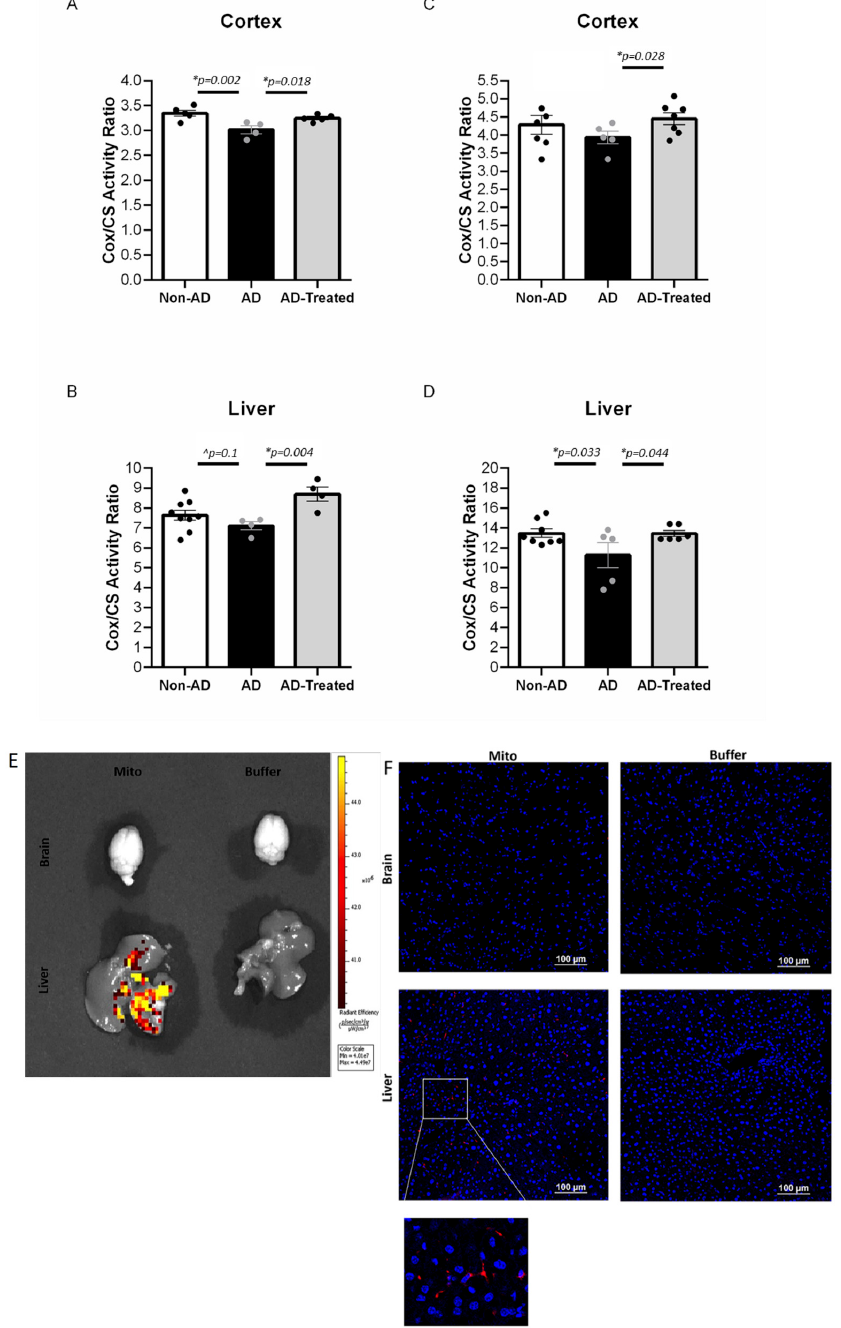
Figure 3. Increased mitochondrial enzymatic activity in the brain and liver of AD mice treated with mitochondrial transfer (A–D). Injected mitochondria are detected in the liver and not in brain (E,F). ( A , B ) COX/CS activity ratio in the brain and liver of 6-month-old treated mice (four injections). ( A ) One-way ANOVA showed a significant difference in brain between the groups [f(2, 11) = 8.064, p = 0.007]. LSD post-hoc analysis showed a significantly lower ratio in AD vs. non-AD